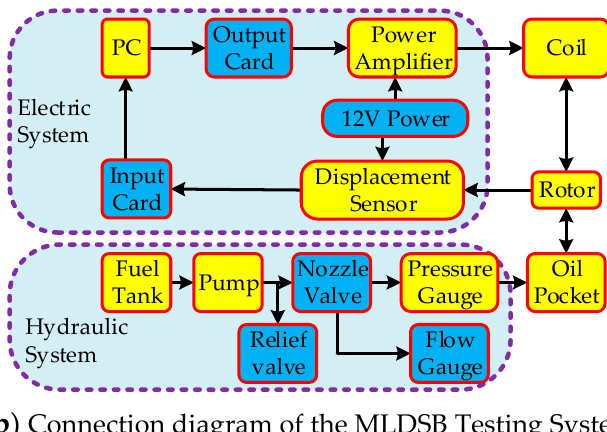
Figure 16. MLDSB Testing System.